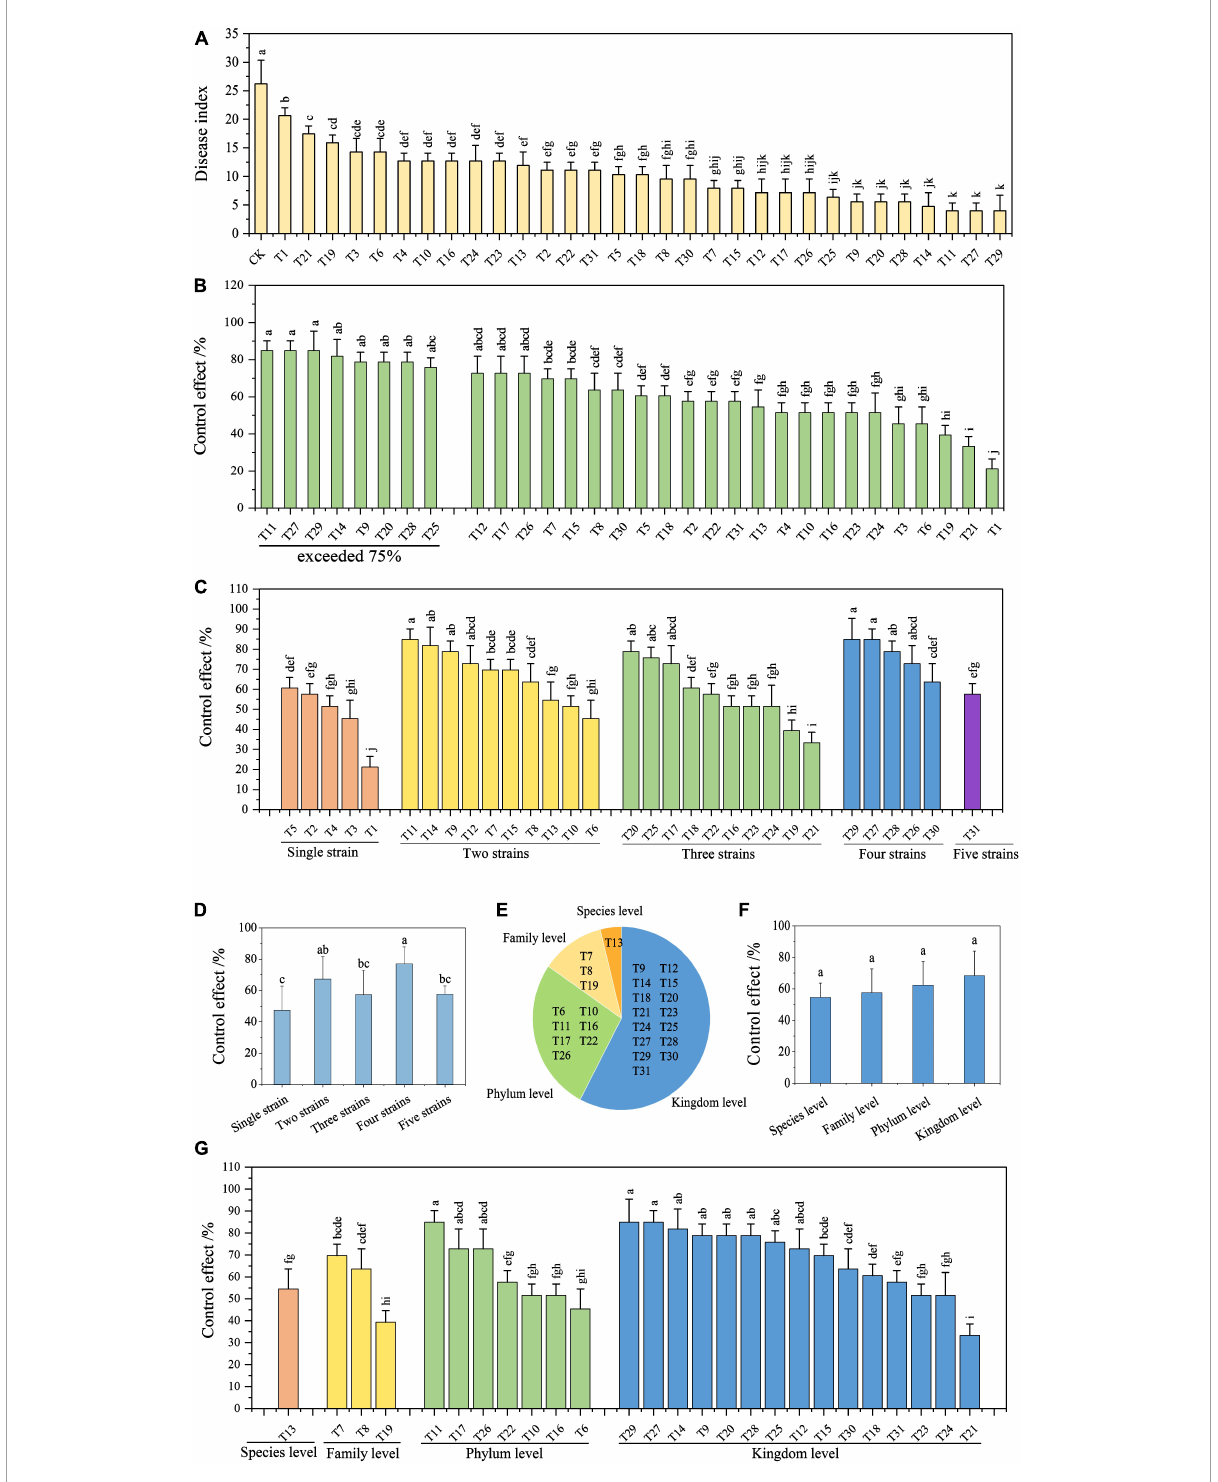
FIGURE3 Efficiency of biocontrol strains and their combinations in controlling Fusarium wilt of banana. (A) Disease index of infected banana seedlings. (B) Control effect of each treatment on Fusarium wilt of banana. (C) Analysis of the control effect based on the strain number in the combinations. (D) Average control effect of combinations with a different number of strains. (E) Groups of biocontrol strain combinations based on genetic relationship differences. (F) Average control effect of combinations with genetic relationship differences. (G) Analysis of control effect based on genetic relationships in the combinations. Different lowercase letters above the bars denote significant differences among treatments ( P <